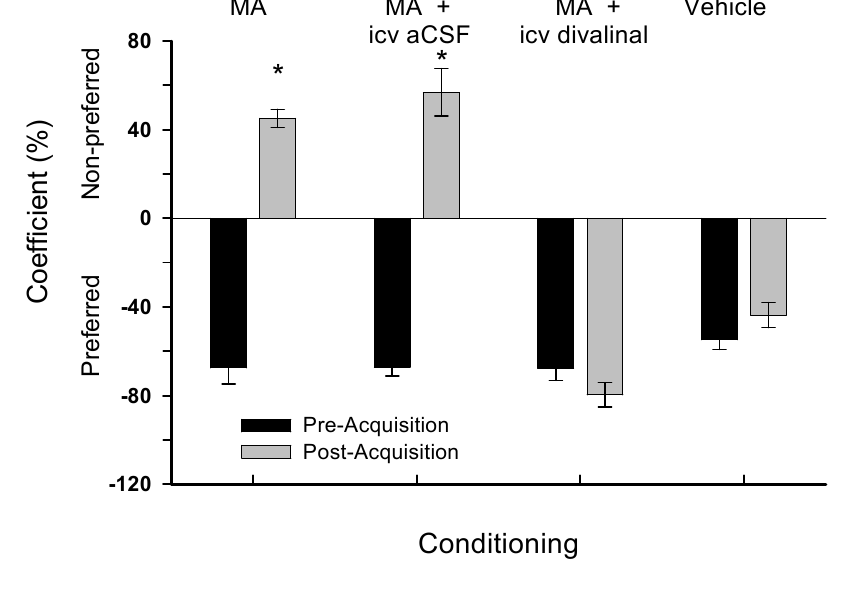
received acute infusions. * p <